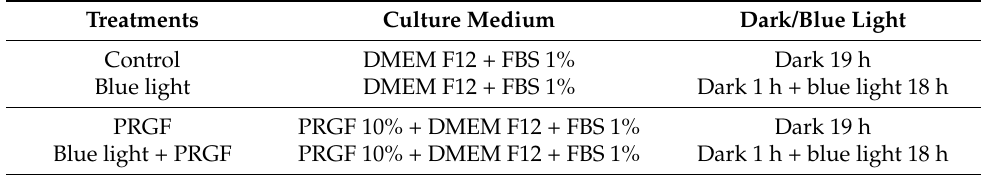
Table 1. Treatments.